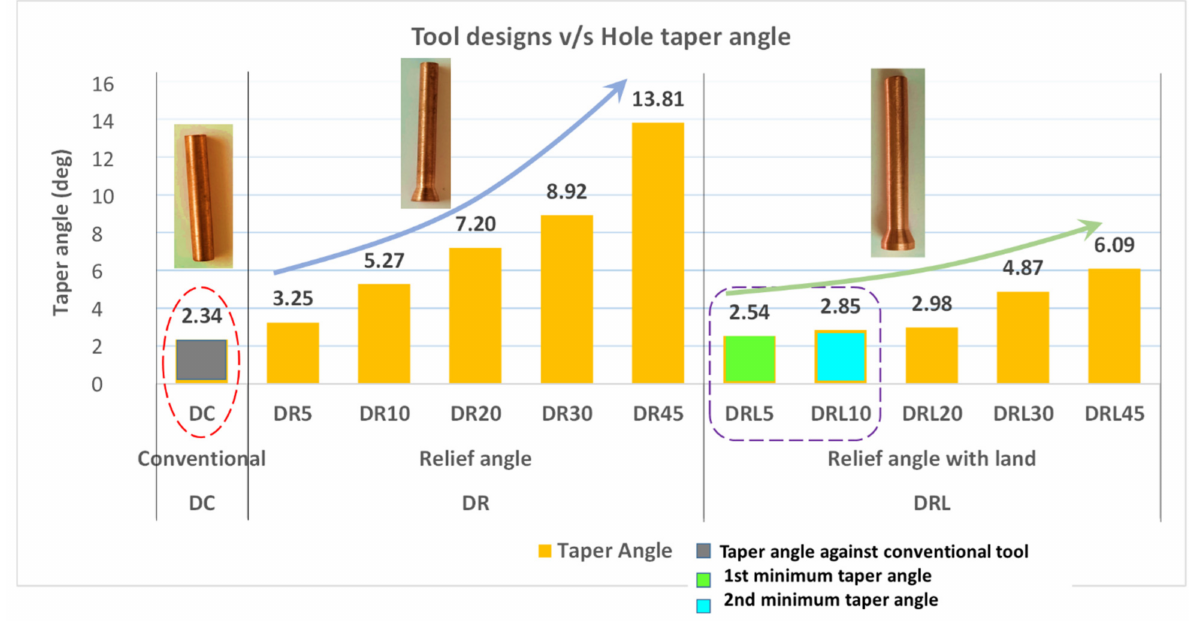
Figure 8. Comparison of hole taper angle under the use of different electrode